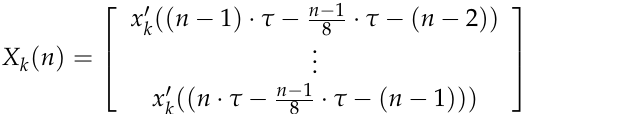
Appl. Sci. 2021 , 11 , x FOR PEER REVIEW